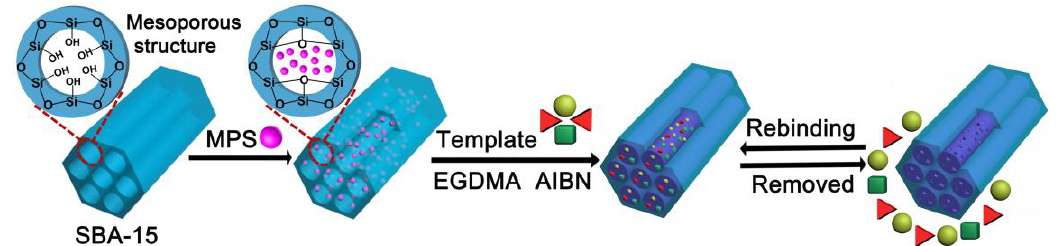
Figure 1. Schematic representation for the preparation of the SBA-15@MT-MIPs.